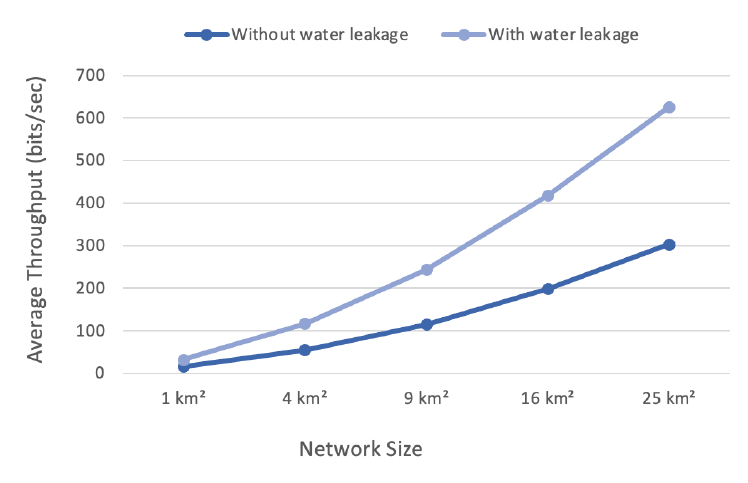
Figure 7. Throughput versus network size.